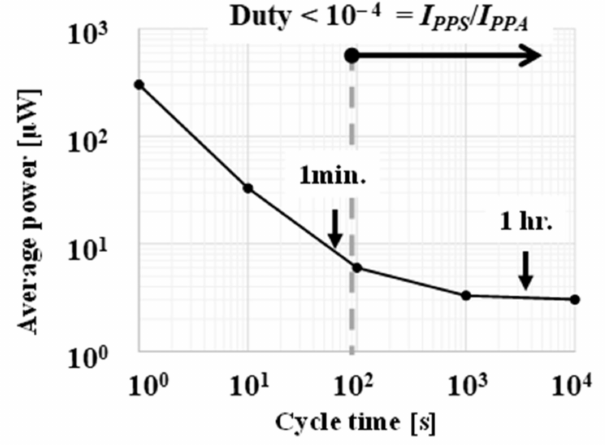
Figure 3. Average power of a sensor module as a function of the cycle